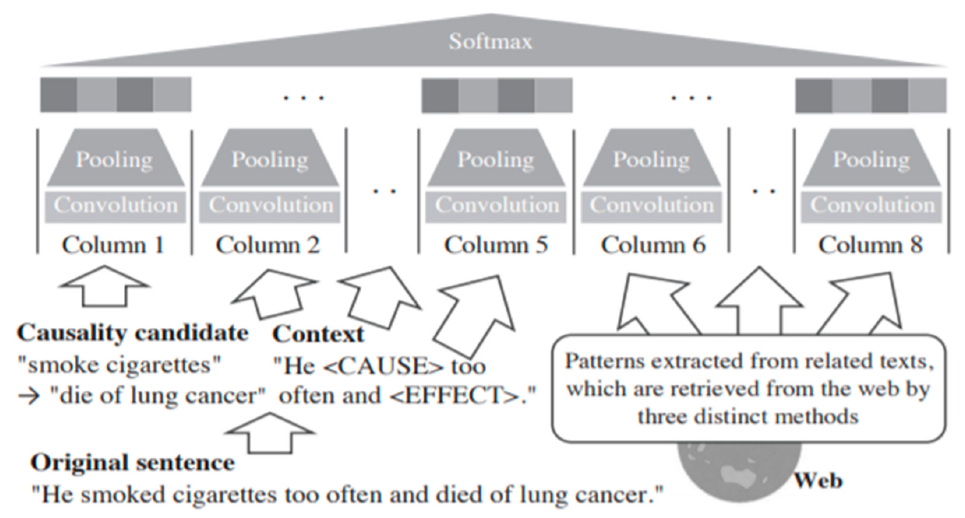
Figure 7. MCNNs Architecture for improving causality mining [174].